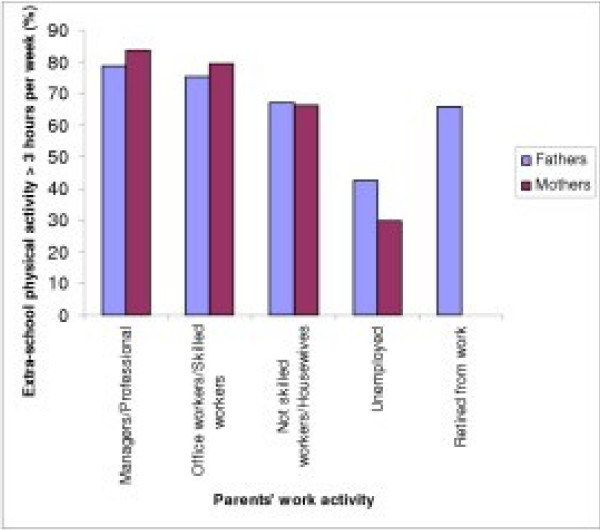
Relation between students' hours of extra-school physical activity and parents' work activity.